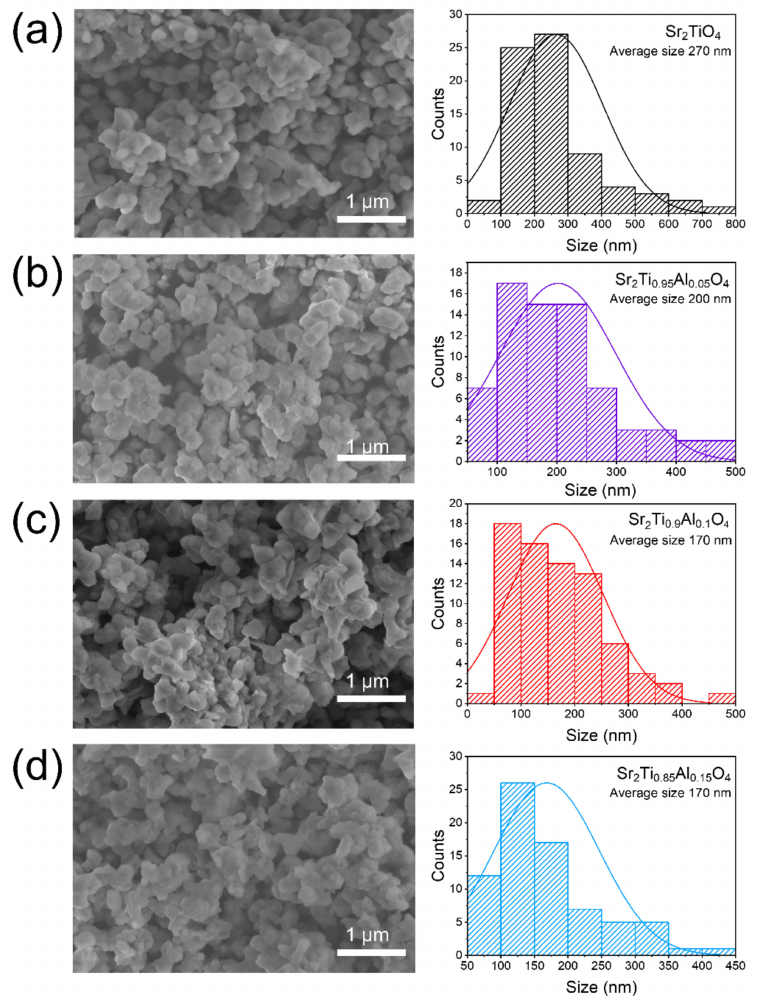
Figure 2. SEM images and the corresponding grain-size histograms of ( a ) Sr 2 TiO 4